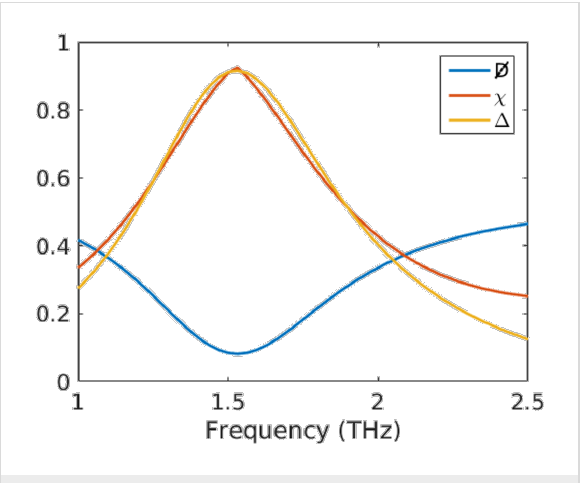
We clearly see the anticipated minimum in the duality breaking. nance frequency. Simultaneously the chirality reaches a maximum of 0.9, which means that the object responds differ- ently to the two opposite polarizations of illuminating